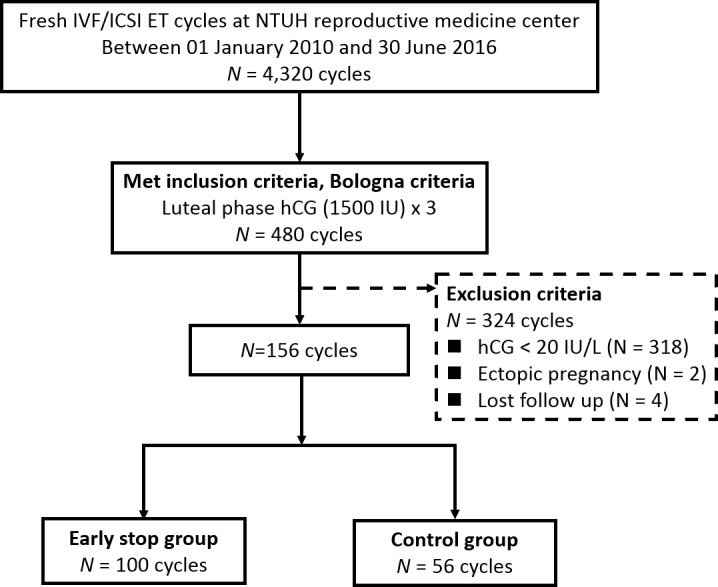
Flow chart of study procedures.From eligible 4,320 cycles with the initial criteria of fresh ET, 480 cycles met the Bologna criteria of POR. Finally, 156 cycles were selected after screening with exclusion criteria. At every follow-up visit, regular evaluations and assessments were made in both groups.Totally, 156 cycles with POR received fresh ET using LPS consisting of three doses of hCG (1500IU) plus Crinone 90 mg qd beginning 2 days after OPU were included in this study. One hundred cycles were in the study group with early stop of progesterone and 56 were in the control group without early stop. There were no statistically significant differences observed in baseline characteristics between two groups, as age (39.5 ± 3.8 vs. 39.9 ± 3.1 year; P = 0.51), body mass index (BMI) (21.8 ± 2.5 vs. 22.3 ± 2.8 kg/m2; P = 0.34), causes of infertility (P = 0.91), gravida (0.91 ± 1.1.5 vs. 0.96 ± 0.94; P = 0.77), parity (0.25 ± 0.55 vs. 0.16 ± 0.41; P = 0.26), previous artificial abortion (0.14 ± 0.37 vs. 0.21 ± 0.49; P = 0.33), spontaneous abortion (0.48 ± 0.79 vs. 0.52 ± 0.71; P = 0.77) and ectopic pregnancy (0.05 ± 0.26 vs. 0.04 ± 0.19; P = 0.69). The general demographics of the patient cohort are listed below (Table 1).